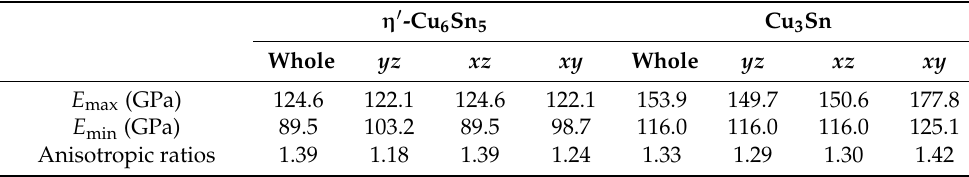
Figure 3. Cross-sections of E in the yz , xz , and xy planes for η (cid:48) -Cu 6 Sn 5 and Cu 3 Sn: ( a ) the yz plane; ( b ) the xz plane; ( c ) the xy plane. The green and red lines denote the cross-sections for η (cid:48) -Cu 6 Sn 5 and Cu 3 Sn, respectively. Table 6. The anisotropic ratios, maximum and minimum values of E for η (cid:48) -Cu 6 Sn 5 and Cu 3